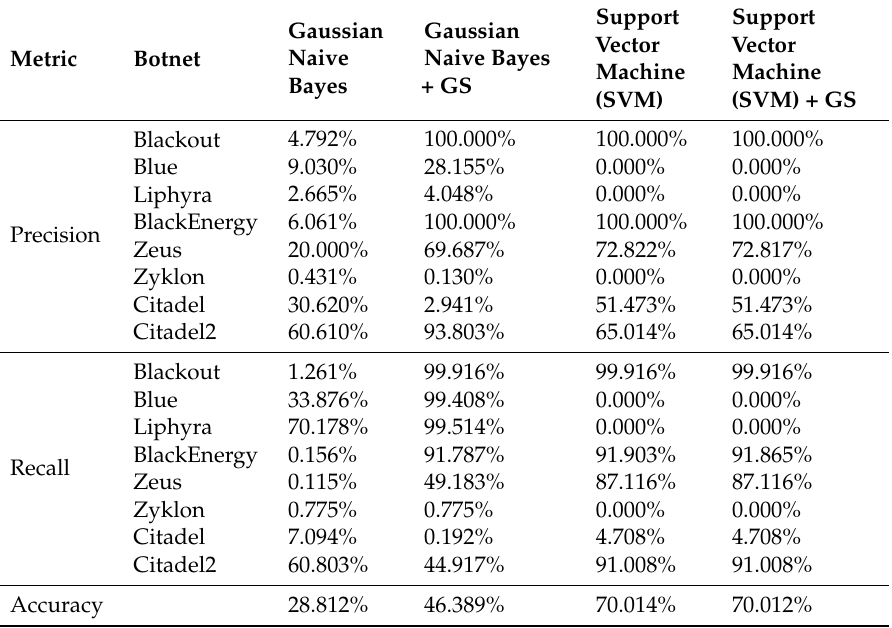
Table 6. Comparative analysis of ML models in the ISOT HTTP Botnet dataset (B).